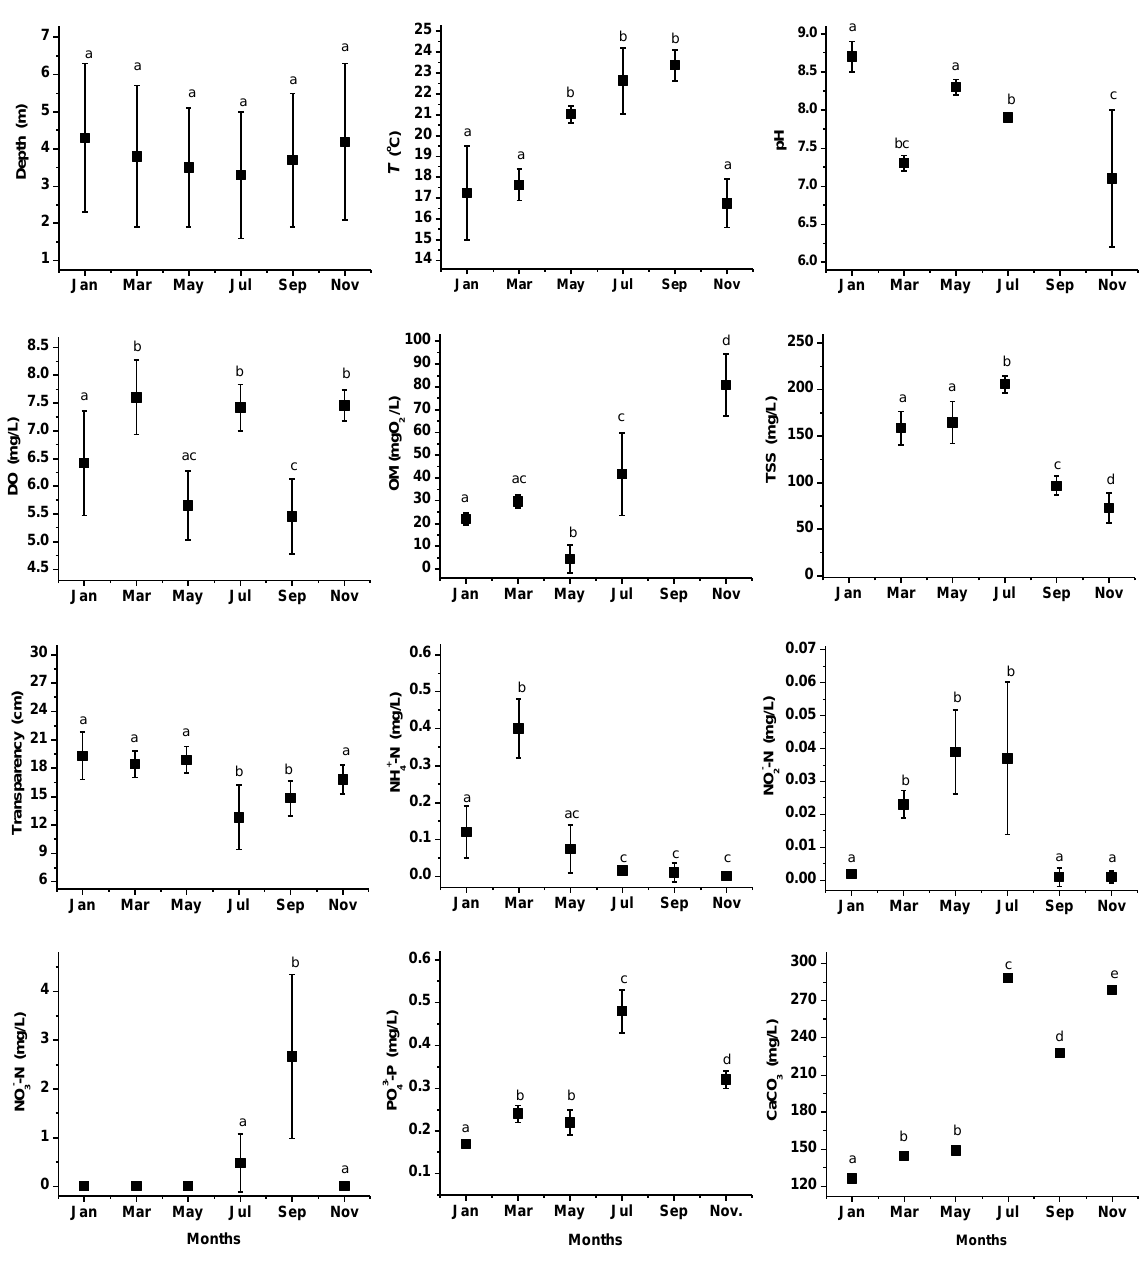
Figure 3. Physical and chemical parameters obtained for the reservoir during the 6 sampling months. Standard deviation (SD) bars correspond to the dates registered for the eight sampling stations within the reservoir. Dissimilar lowercase letters on the SD bars indicate significant differences in Tukey multiple comparison